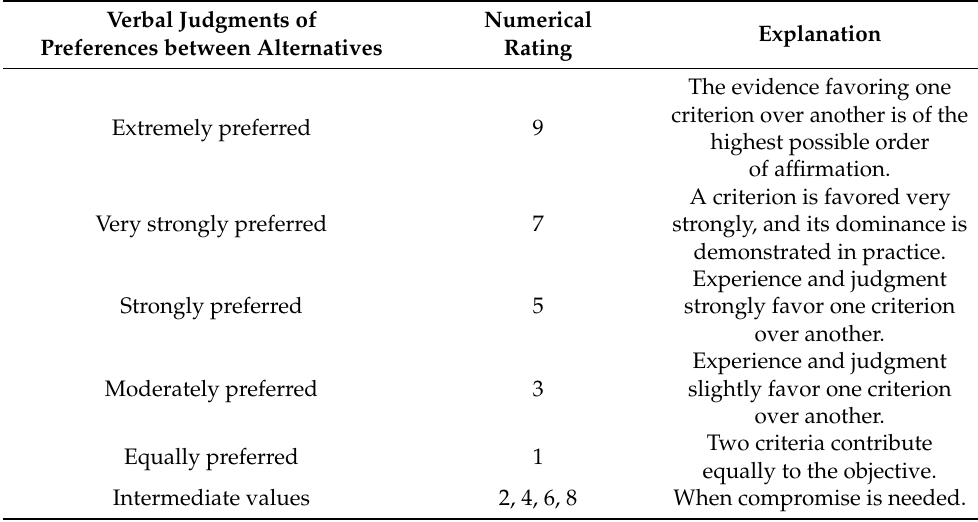
Table 4. Values used in the pair-wise comparison to evaluate the suitability of sites for the develop- ment of solar farms